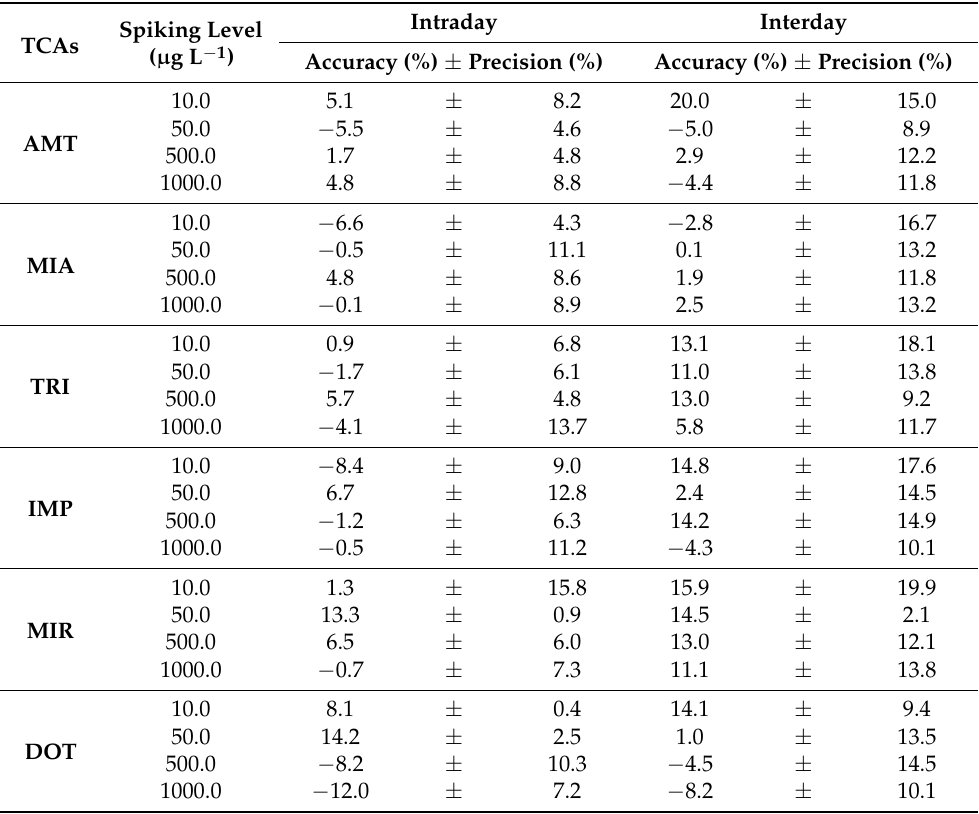
Table 3. Inter and intraday accuracy and precision levels obtained for the six TCAs at four different concentrations by BA µ E(C18)- µ LD/LVI-GC-MS(SIM) methodology, under optimized experimen- tal conditions.